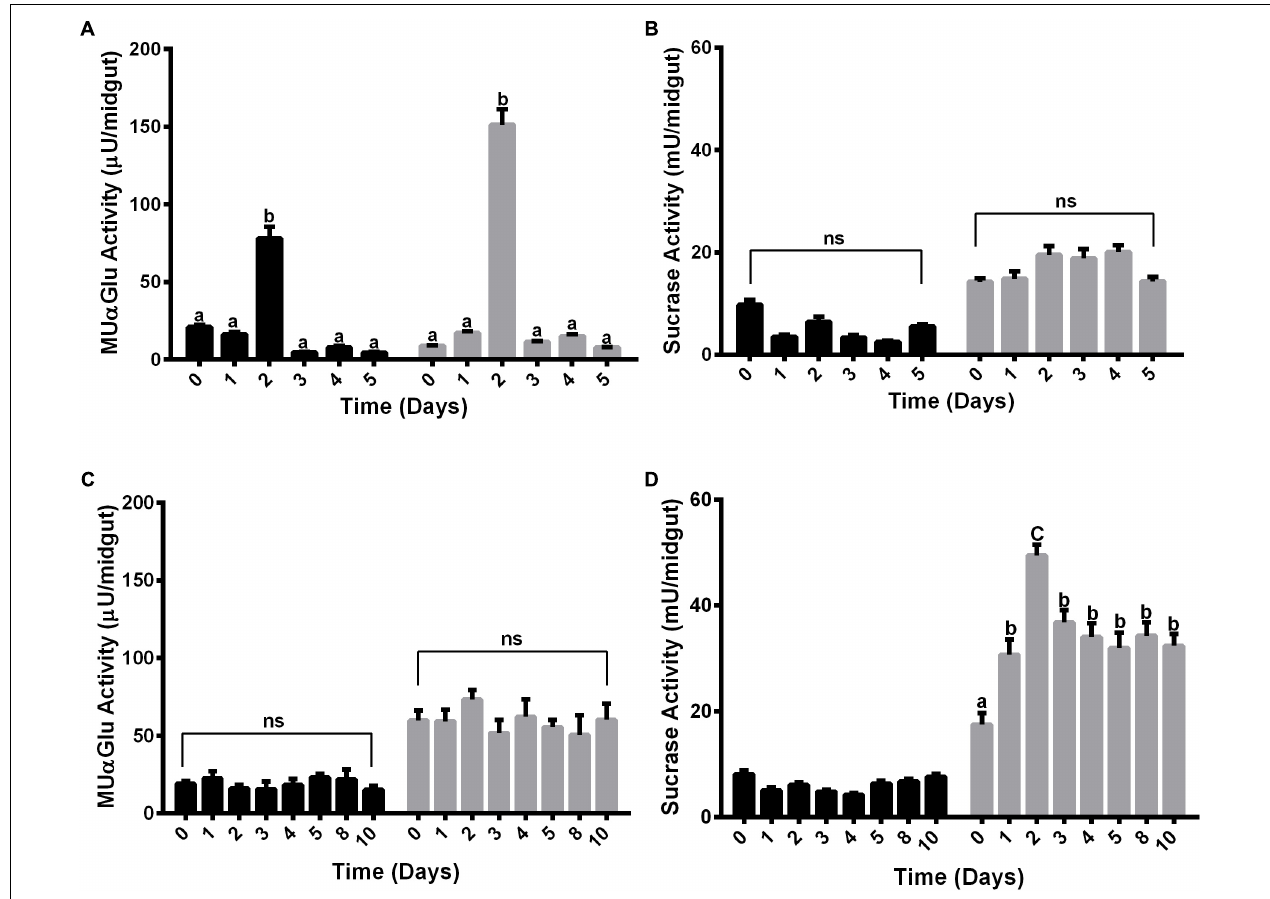
FIGURE 2 | α -Glucosidase activity in different tissues of L. longipalpis females feeding on water (A,B) or 1.2 M sucrose (C,D) . For each feeding condition, the midgut contents (black bars) and midgut tissues (gray bars) were analyzed. Activity was determined using MU α Glu (A,C) or sucrose (B,D) as substrates. Numbers in the x -axis represent the time of exposure to water or sucrose after adult emergence. The results are the mean ± SEM of three biological replicates each with n = 15. One-way ANOVA, followed by Tukey multiple comparison test. Different letters indicate statistically significant different groups, p < 0.05. ns, non-significant